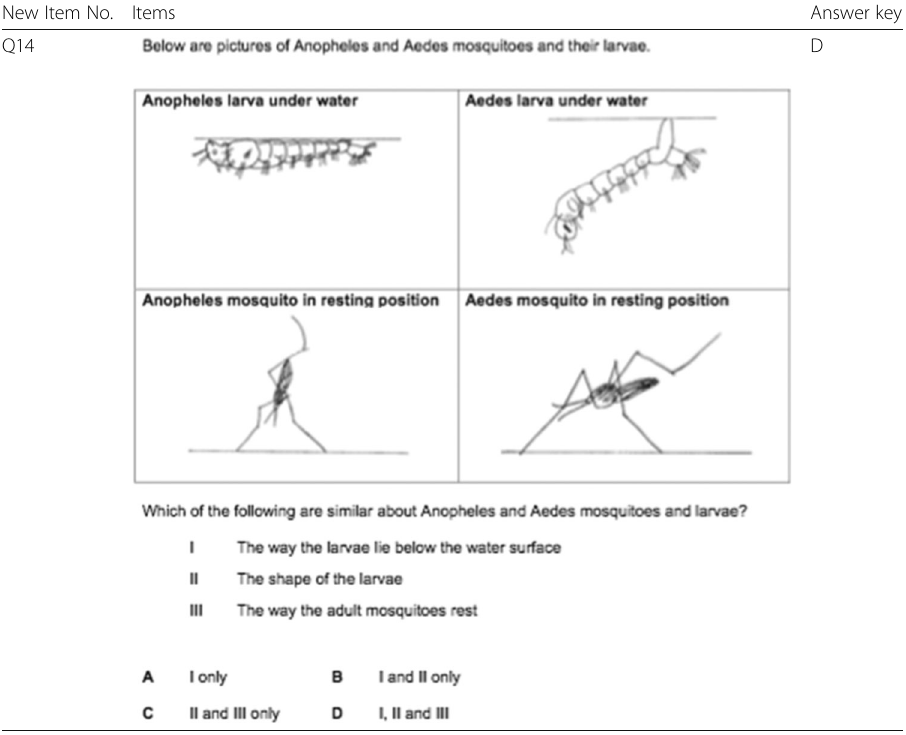
Table 2 The second most difficult item — Item 14 New Item No.